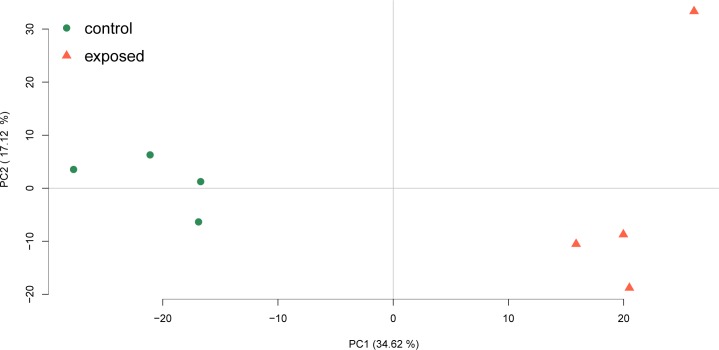
PCA score-plot of the z-scored label free quantification intensities.A clear separation can be observed on the PC1 level, which explains 34.62% of the data’s variance, between the UVC/vacuum treated samples (red) and the control samples (green).